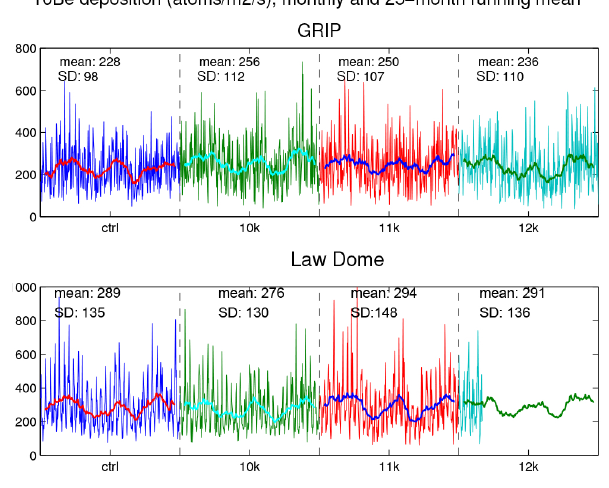
Fig. 6. The input data for the EEMD analysis: normalised 25-month running mean 10 Be production (blue), deposition (red) and precipitation (black) at the GRIP and the Law Dome stations.